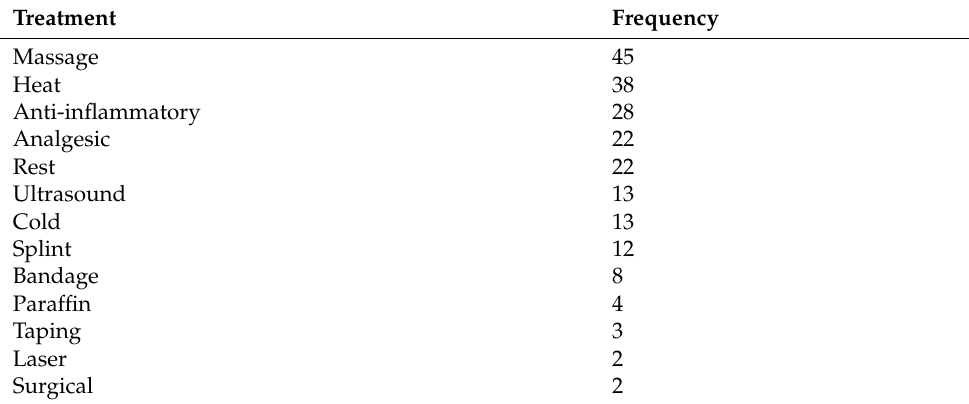
Table 3. Upper limb treatments received by participants ( n = 62).